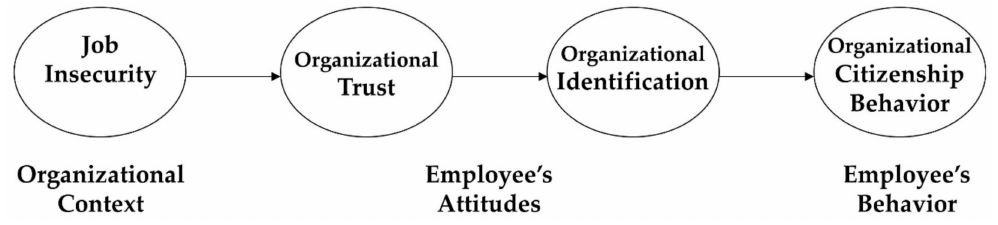
Figure 1. The framework of the research model.